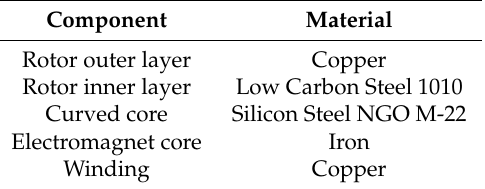
Table 2. Material components of FEM and lab